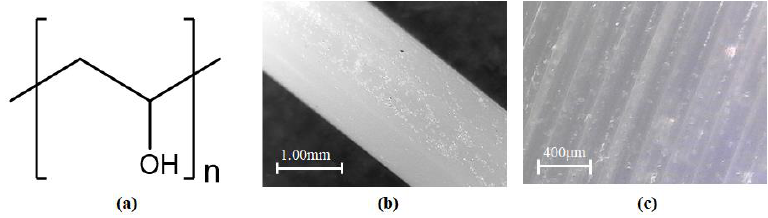
Figure 13. PVA ( a ) chemical structure; ( b ) raw material; and ( c ) final processed material.